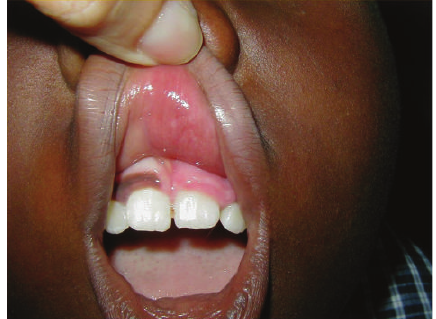
Figure 3: Photograph demonstrating a discoloration of the gum in the left side, consistent with capillary